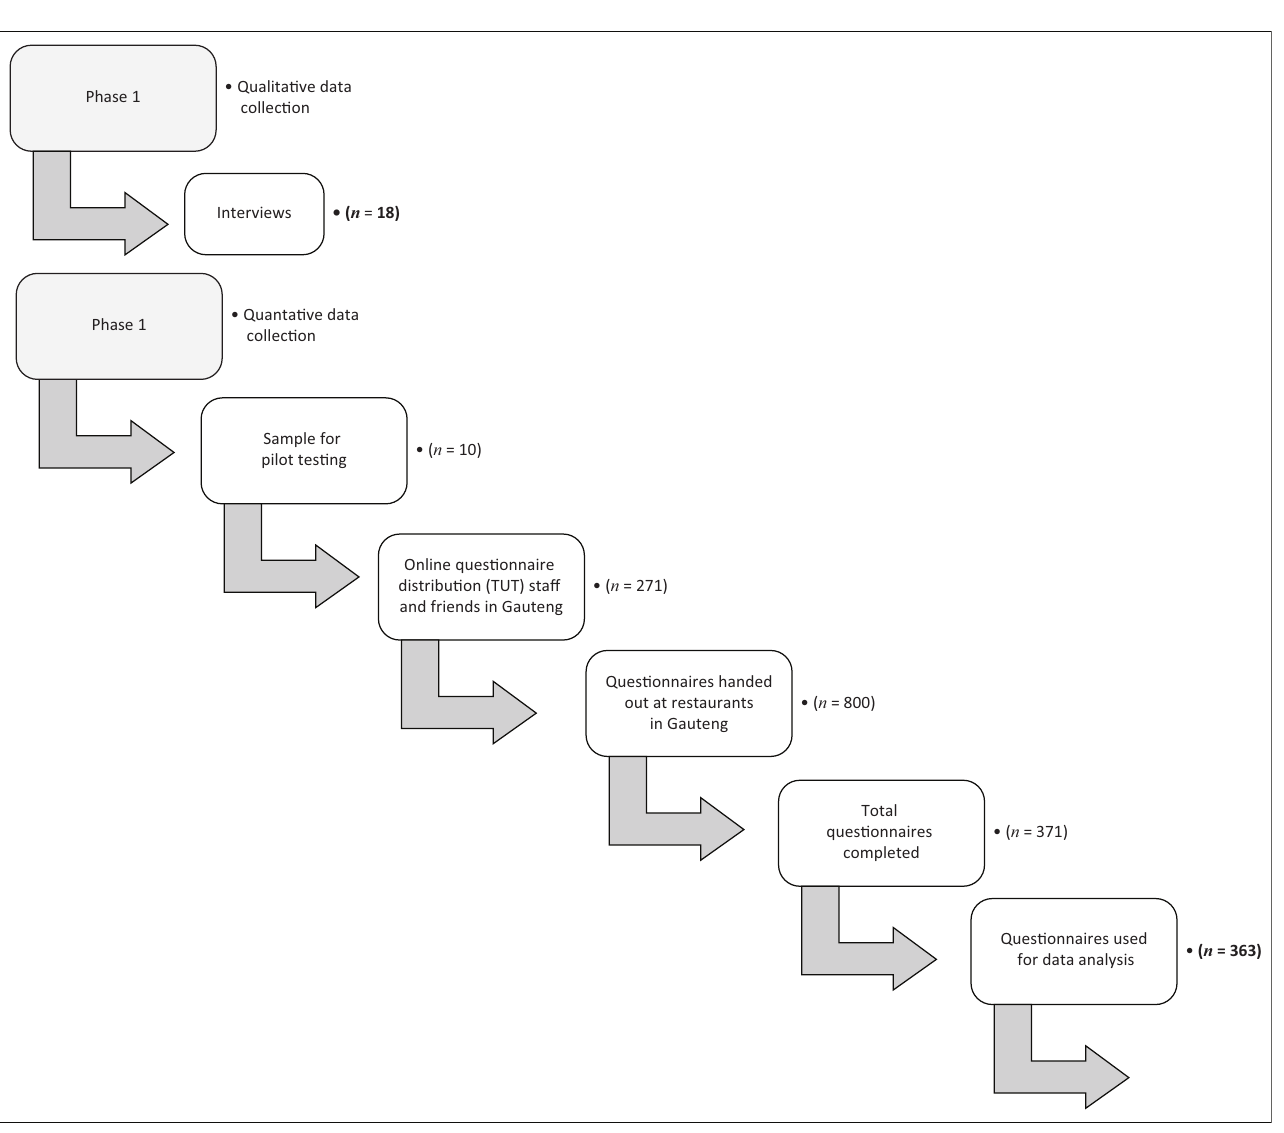
FIG URE 1: Sample selection method for this study.